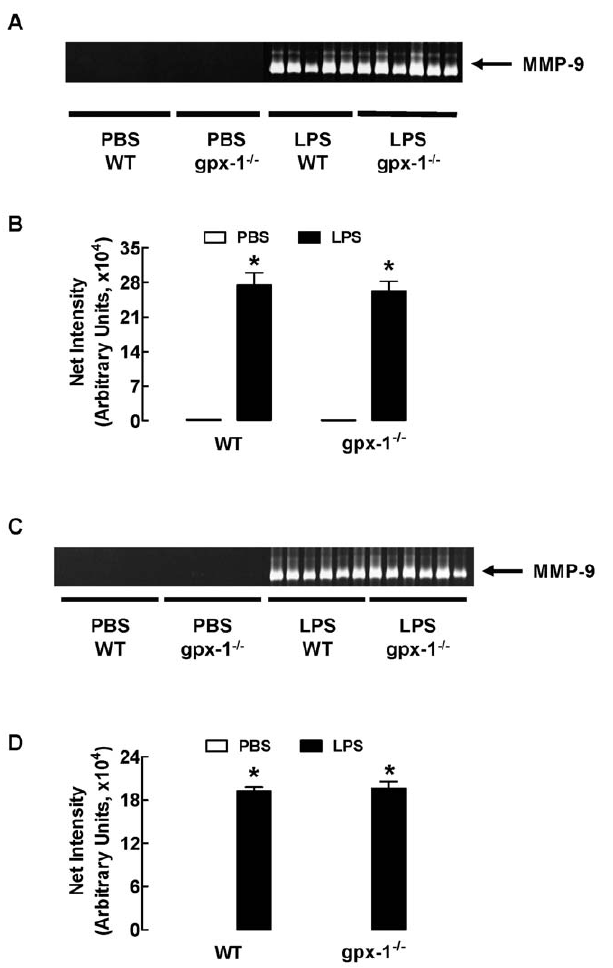
Figure 2. Effect of LPS treatment on MMP-9 expression in BALF of WT and gpx-1 2 / 2 mice. WT and gpx-1 2 / 2 mice were treated with LPS (10 m g/mouse) for 3 h (Panel A) and 24 h (Panel C) and MMP-9 expression in BALF of individual mice measured by zymogarphy. Panels A & C show MMP-9 assayed by gelatin zymography under reducing conditions and Panels B & D are the respective densitometric measurements. Densitometry data are shown as mean 6 SEM for 5–6 mice per treatment group. Clear bars represent PBS-treated mice and black bars represent LPS-treated mice. * P , 0.05 vs respective PBS- treated mice (ANOVA and Bonferroni’s post hoc test).